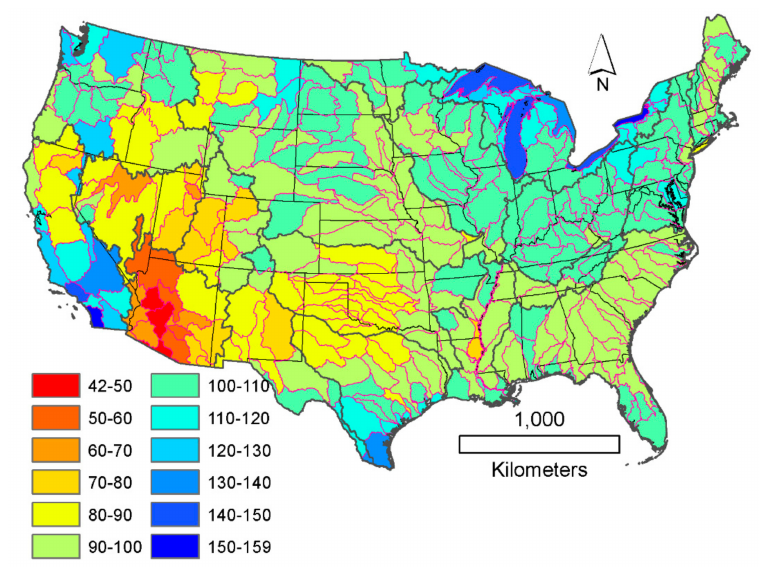
Figure 9. Spatial distribution of the relative errors (%) in the long-term (1979–2015) mean annual HUC6 precipitation rates. The seven HUC6 basins with outlier streamflow rates (Figure 1) are left in the map for spatial continuity.